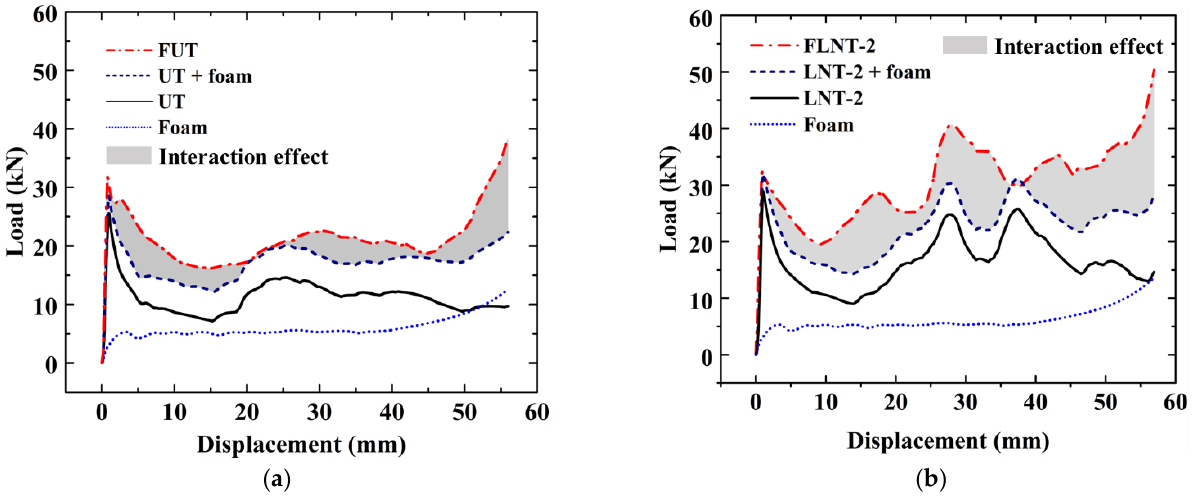
Figure 7. The interaction effect of foam-filled tubes: ( a ) UT and ( b ) LNT-2. Table 4. Effects of foam on energy absorption for thin-walled tubes.